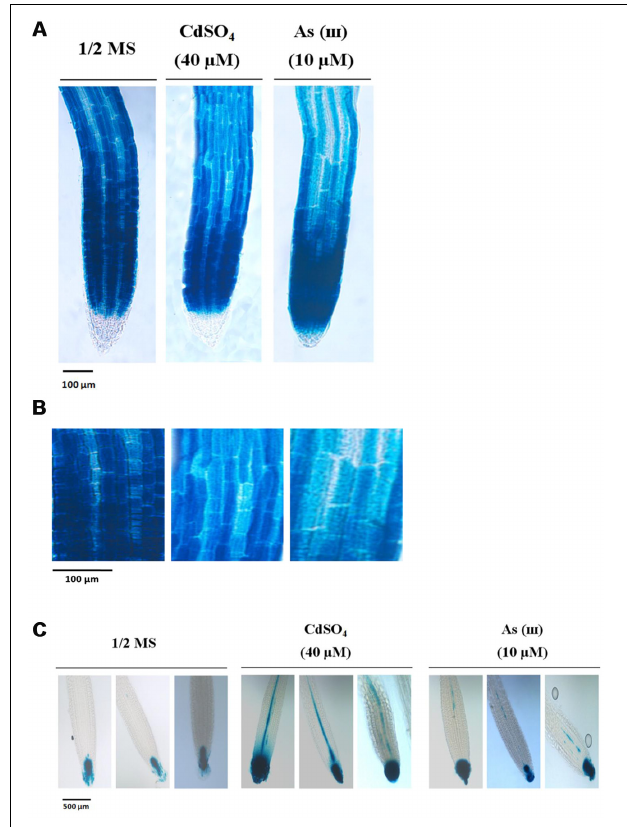
FIGURE 4 | Down-regulation of GL2 and up-regulation of DR5 by cadmium and arsenite in Arabidopsis root. (A) GUS activity of primary root tips (2 mm) of 5-day-old transgenic Arabidopsis Col -0 seedlings carrying the GL2 - GUS construct. Plants were germinated and grown in 1/2 MS media supplemented with or without cadmium and arsenite, and were stained to visualize GUS activity (20 × magnification). (B) GUS activity at higher magnification (40 × ). Left panel, 1/2 MS media; central panel, 1/2 MS media with 40 µ M CdSO 4 ; right panel, 1/2 MS media with 10 µ M As(III). Scale bar indicates a 200 µ m in size. Each photograph represents five plants. (C) GUS activity of primary root tips (2.3 mm) of 5-day-old transgenic Arabidopsis Col -0 seedlings carrying the DR5 - GUS construct. Plants were germinated and grown in 1/2 MS media supplemented with or without cadmium and arsenite, and were stained to visualize GUS activity (20 × magnification). Left panel, 1/2MS media; central panel, 1/2 MS media with 40 µ M CdSO 4 ; right panel, 1/2 MS media with 10 µ M As(III). Scale bar indicates a 500 µ m in size. Each photograph represents five